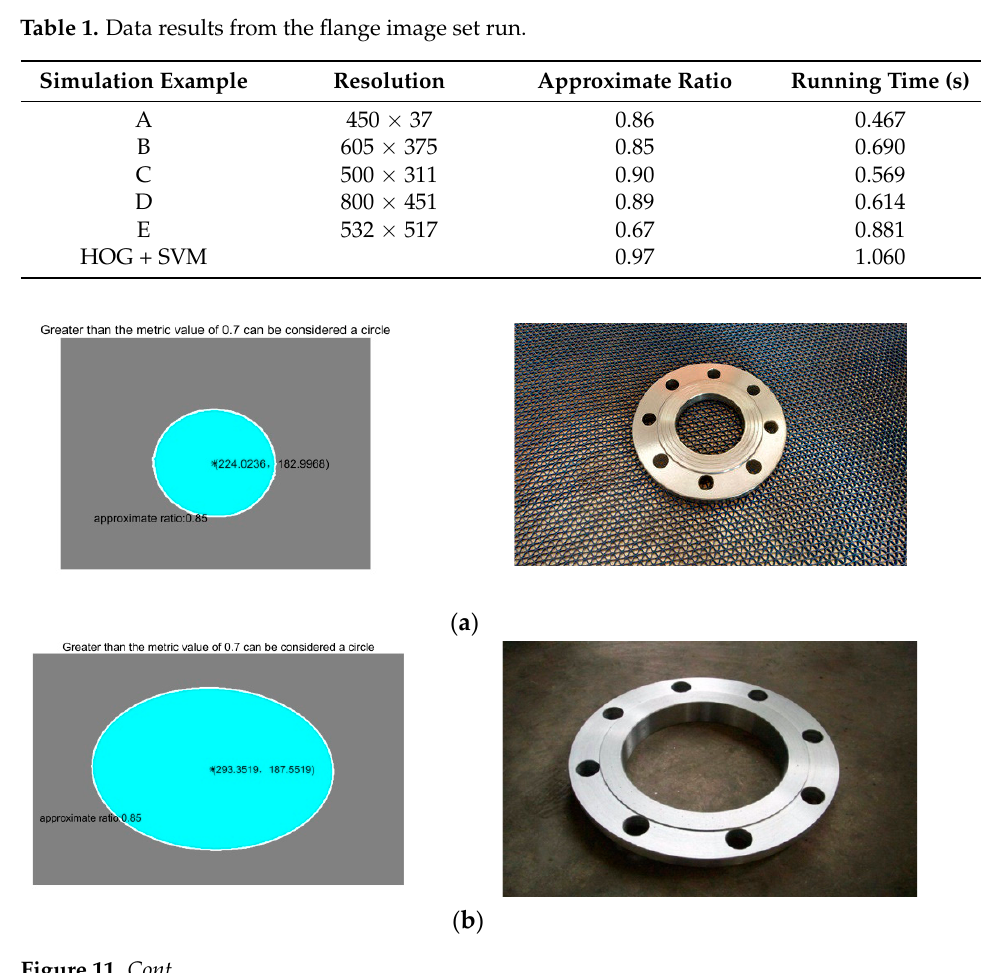
Figure 10. The circle center absolute error distribution curve along the X and Y axes.